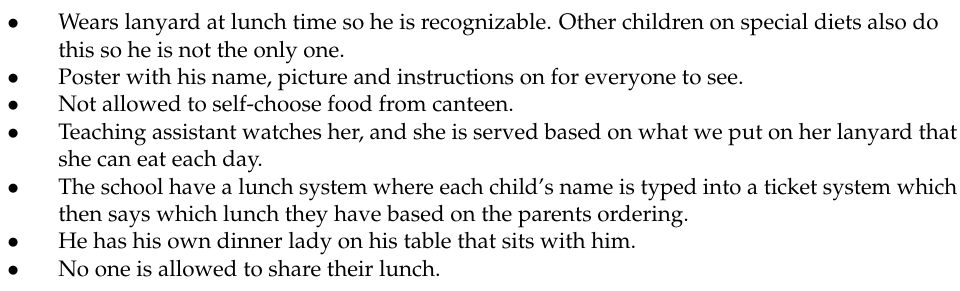
Table 4. All strategies suggested by parents/caregivers to prevent incorrect foods being eaten by children with PKU in